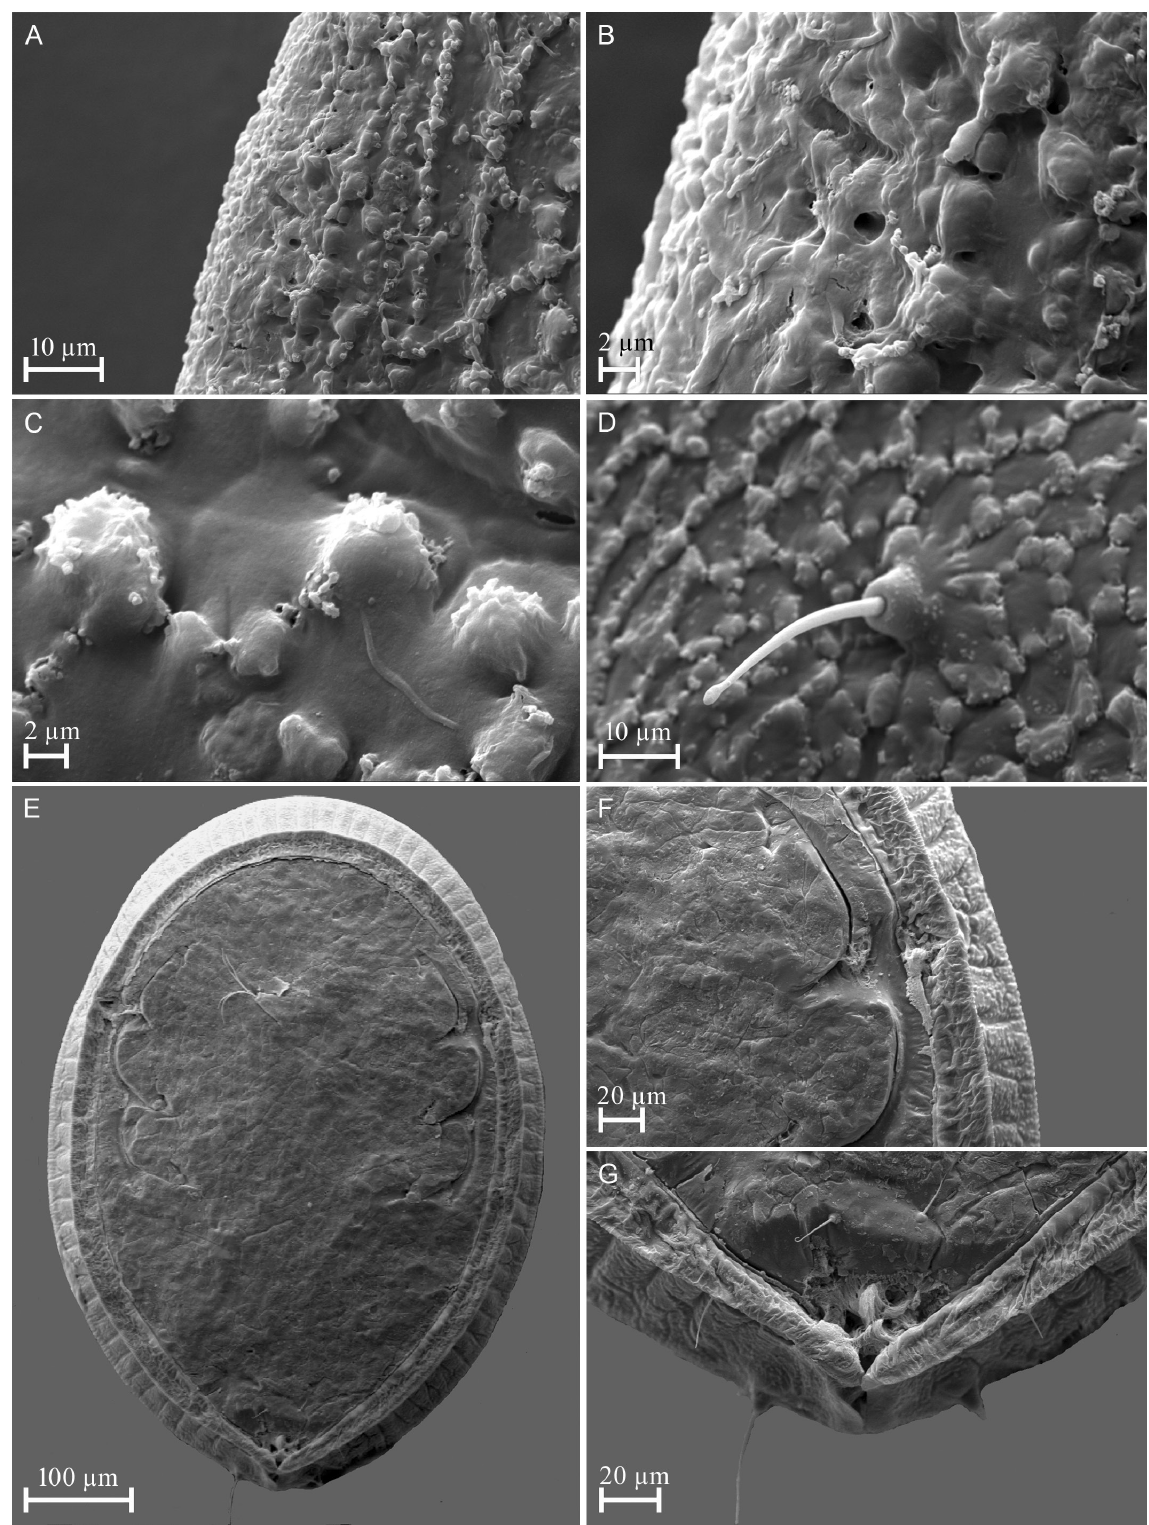
Fig. 6. Rudisculptus caudalis gen. et sp. nov., puparium, not preserved, SEM images, dorsal and ventral surfaces. A . Microtubercles, dorsal surface. B . Same, enlarged view. C . Geminate pore. D . Cephalic seta. E . Puparium, ventral surface. F . Thoracic tracheal fold. G . Caudal tracheal